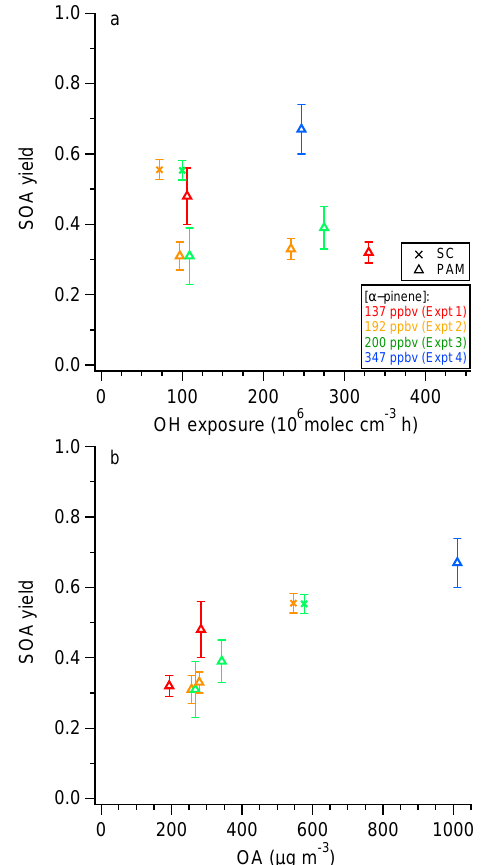
Figure 2. SOA yields determined using the PAM and the SC from α -pinene photo-oxidation experiments as a function of (a) OH ex- posure and (b) organic aerosol loading. Color designates experi- ment number and marker shape designates aging device. Legend in (a) also applies to (b)